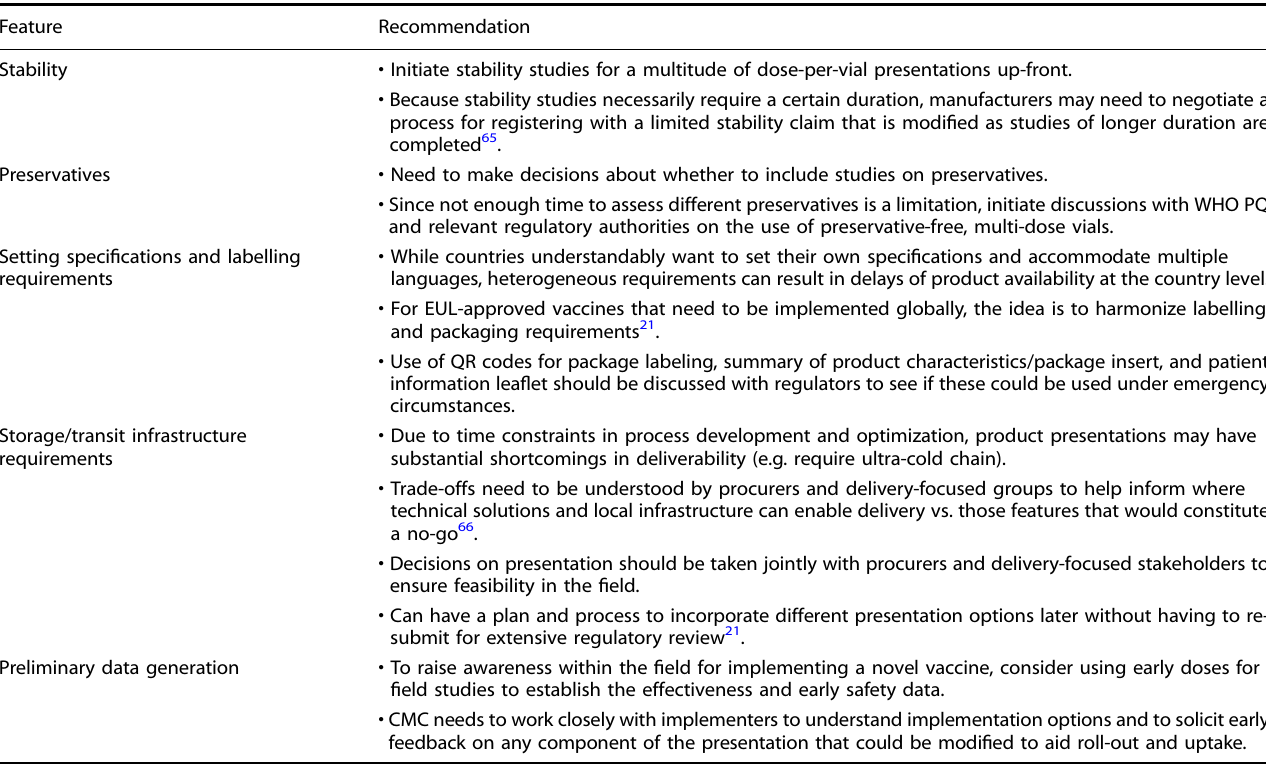
Table 3. Presentation features that may change post-initial EUL. Feature